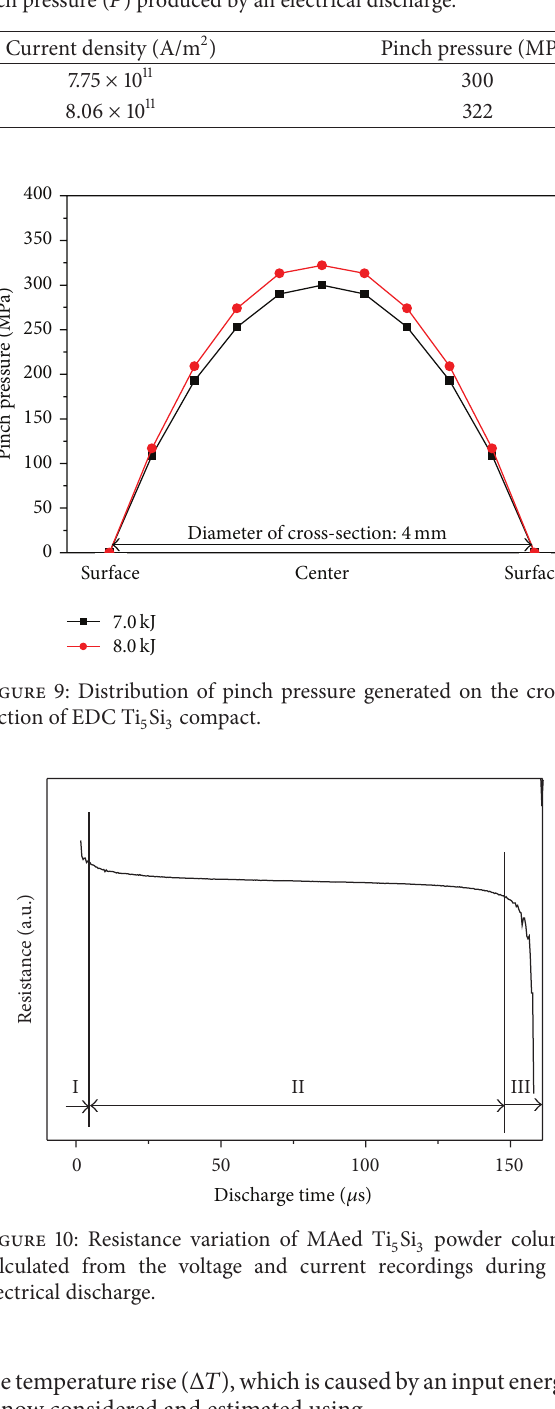
Table 3: Temperature rise ( Δ𝑇 ), current density ( 𝑗 ), and pinch pressure ( 𝑃 ) produced by an electrical discharge.